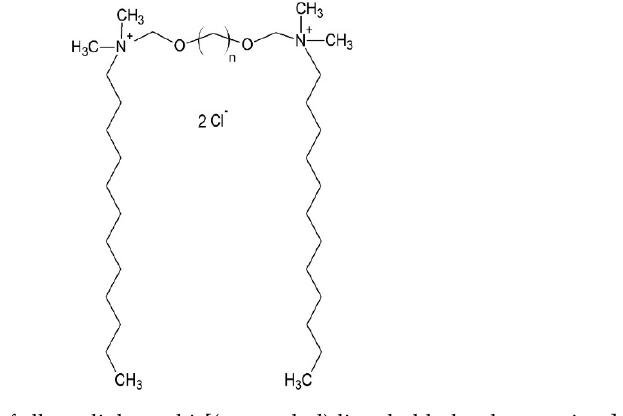
Figure 1. Chemical structure of alkanediyl- α , ω -bis[(oxymethyl)dimethyldodecylammonium] chlorides (C12NCn, n = 2–12).